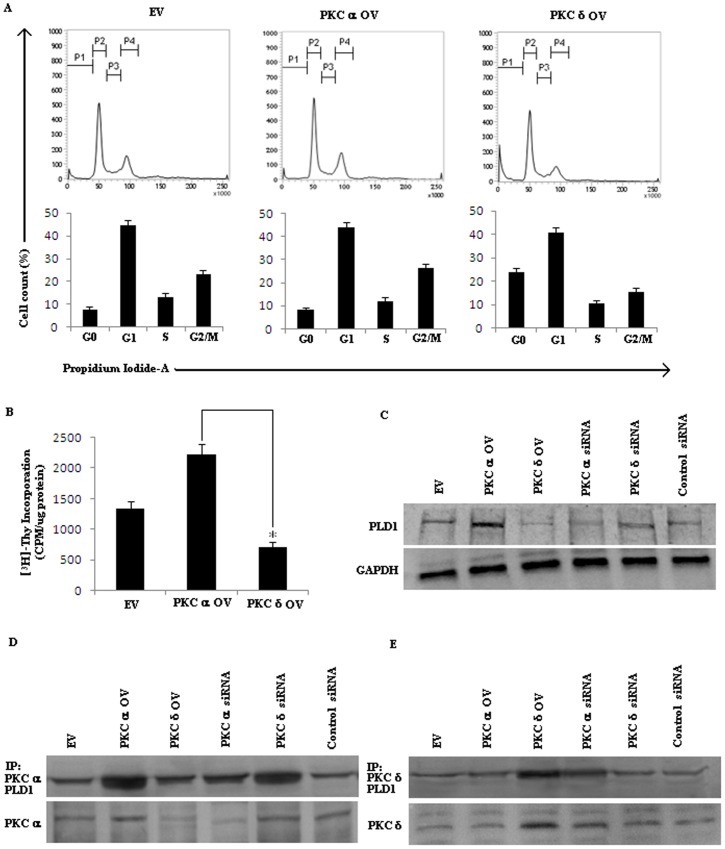
Influence of PKCα and PKCδ on cell proliferation and their interaction with PLD1.(A) B16F10 cells transfected with empty vector (EV) or overexpressed full-length mouse PKCα (PKCαOV) or PKCδ (PKCδOV) isotypes as mentioned in materials and methods were harvested for 48 hrs and stained with propidium iodide to measure the DNA content by flow cytometry. (B) B16F10 cell transfected with EV, PKCαOV and PKCδOV isotypes were measured for incorporation of (3H) - thymidine to determine cell proliferation. (*p<0.001). Expression of PKCδOV compared to PKCαOV. Results were expressed as mean±SD, and are representative of three independent experiments. (C) Whole cell lysates from the stable transfectants of B16F10 cells overexpressing PKCα (PKCαOV), PKCδ (PKCδOV), or the empty vector (EV) and the siRNA oligonucleotides specific to PKCα (PKCα siRNA), PKCδ (PKCδ siRNA) or control siRNA were subjected to Western blot analysis for PLD1 expression. Representative data from three independent experiments was given compared to GAPDH.(D) In a separate set, B16F10 cells transfected with empty vector (EV), full-length mouse PKCαOV and PKCδOV, siRNA oligonucleotides specific to PKCα, PKCδ and control siRNA respectively as mentioned in materials and methods. The whole cell lysates from each transfected cells were subjected to immunoprecipitation with anti Phospholipase D1 (PLD1) antibody and the blots were probed with anti-PKCα respectively. (E) Similarly, the whole cell lysates from each transfected cells were subjected to immunoprecipitation with anti PLD1 antibody and the blots were probed with anti-PKCδ respectively. The blot shown is a representative of experiments performed in triplicate. GAPDH was used as a reference.